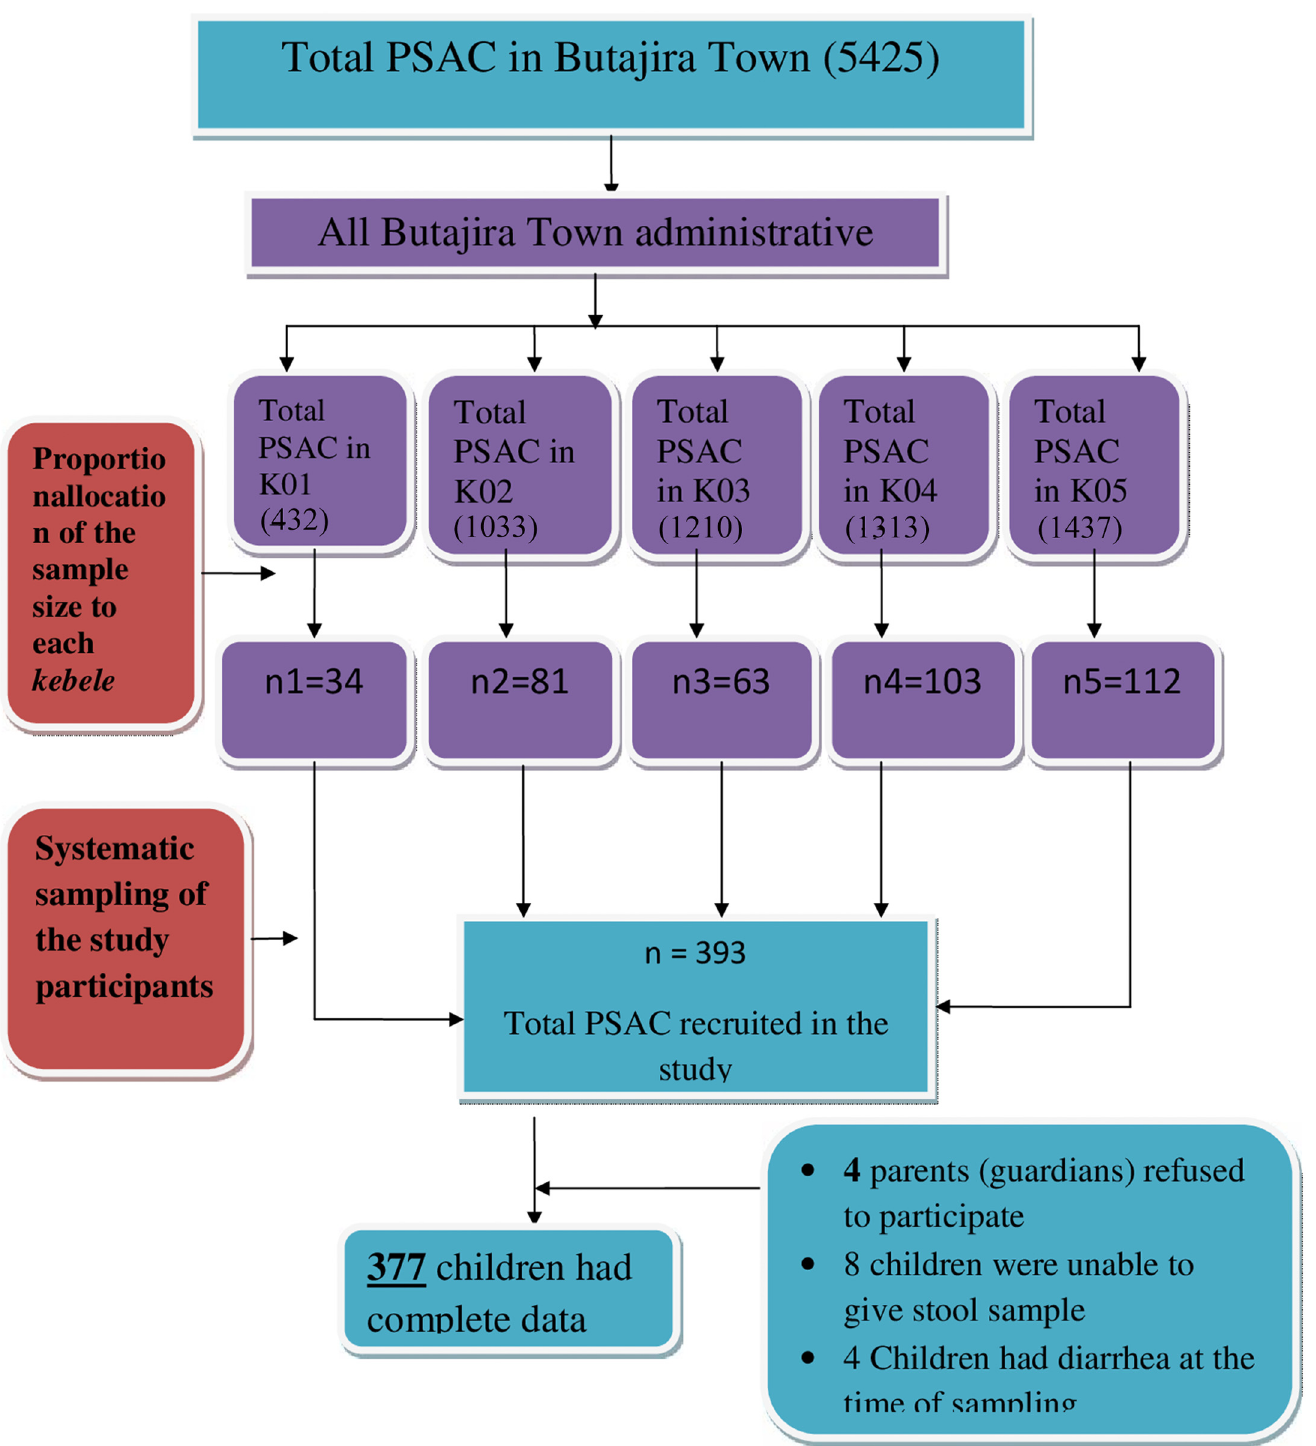
Fig 1. Flow chart of sampling, participation, and compliance of the Preschool aged children in Butajira Town, South-central Ethiopia.